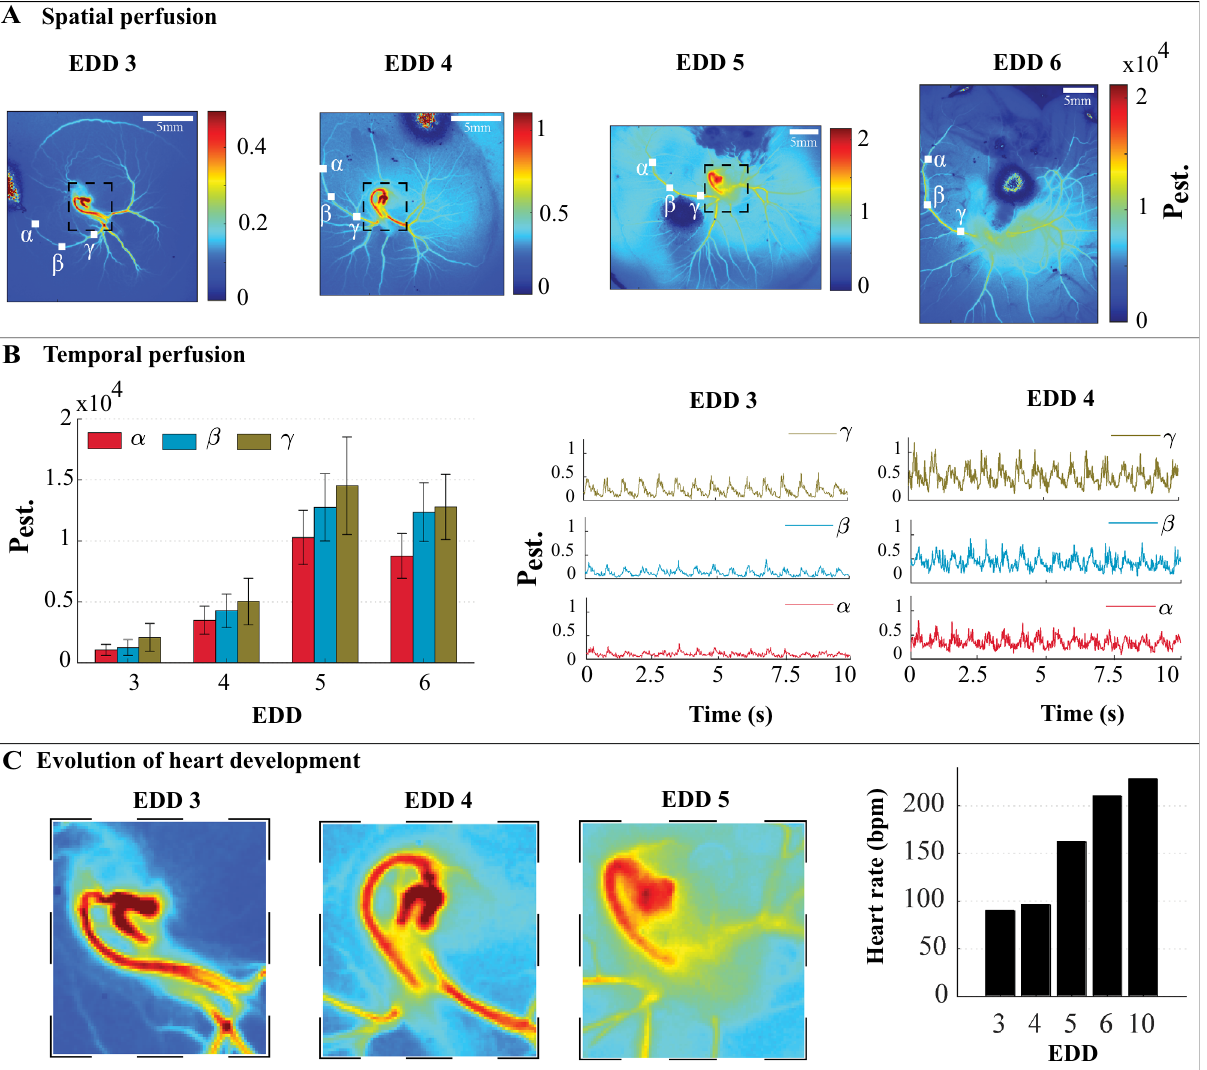
Figure 4. Blood flow distribution of developing vascular networks. Panel ( A ) shows the average spatial perfusion maps of complete vascular network of chick embryo belonging to developmental day 3 till 6. EDD, embryo development day. P est. , estimated perfusion. Panel ( B ) shows the temporal perfusion profile from the regions in Panel ( A ) (highlighted using Greek symbols α = alpha, ß = beta and γ = gamma). Measured perfusion values are obtained from single independent biological sample ( n = 1) over a timeframe of 10 s. Data of bar graph are mean ± standard deviation. Panel ( C ) represents zoomed snapshot of heart development from day 3 till 5 (highlighted regions in panel ( A ) using dashed boxes) and the heart rate of the sample. bpm, beats per